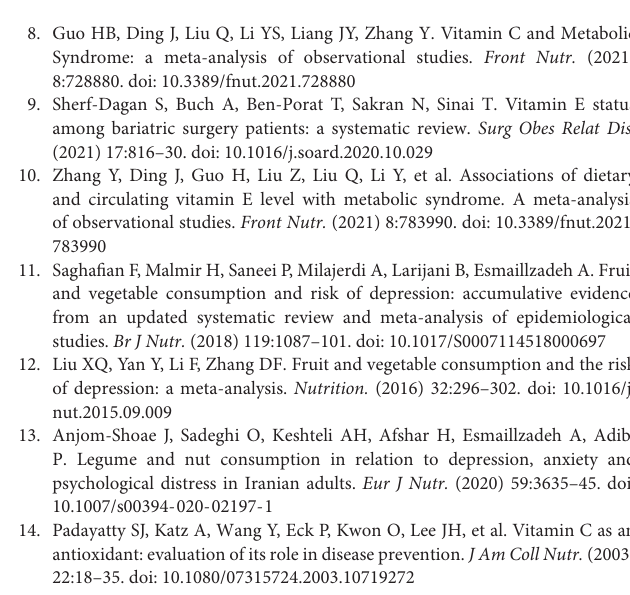
Supplementary Figure 1 | Funnel plot with pseudo 95% confidence limits for the analysis of dietary vitamin C intake and depression. Supplementary Figure 2 | Funnel plot with pseudo 95% confidence limits for the dietary vitamin C intake for depression versus control subjects. Supplementary Figure 3 | Funnel plot with pseudo 95% confidence limits for the analysis of dietary vitamin E intake and depression. Supplementary Figure 4 | Funnel plot with pseudo 95% confidence limits for the dietary vitamin E intake for depression versus control